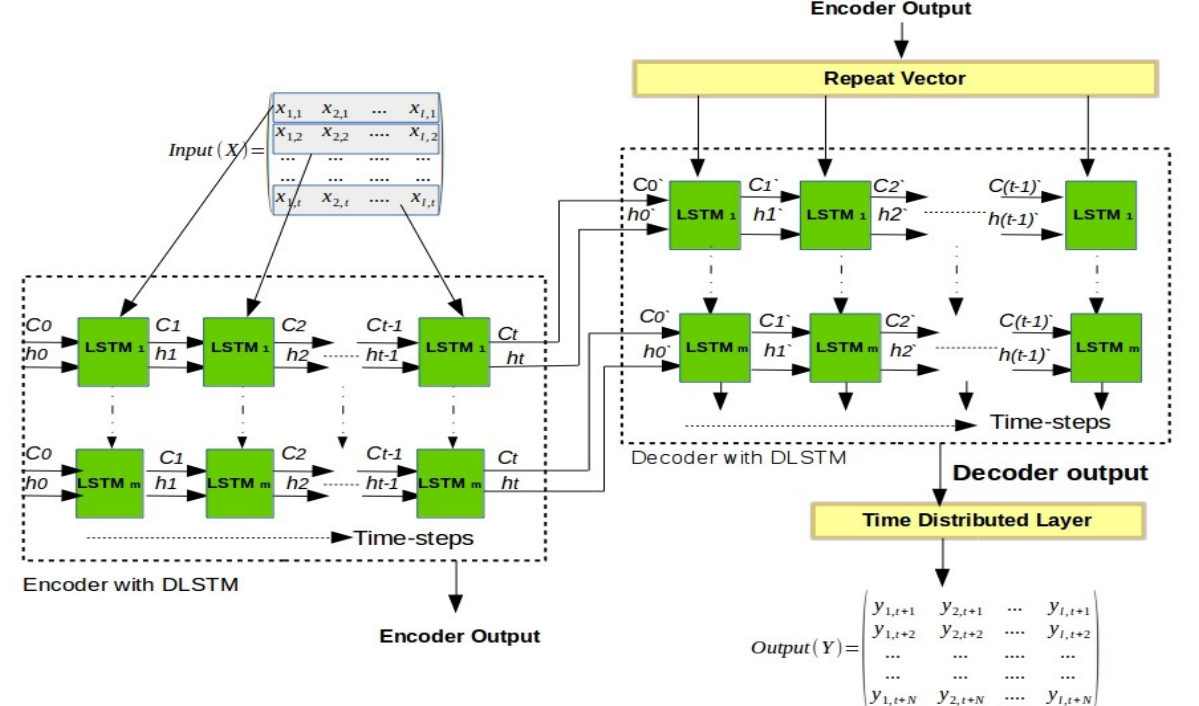
Figure 5. The DLSTM-based Auto-Encoder